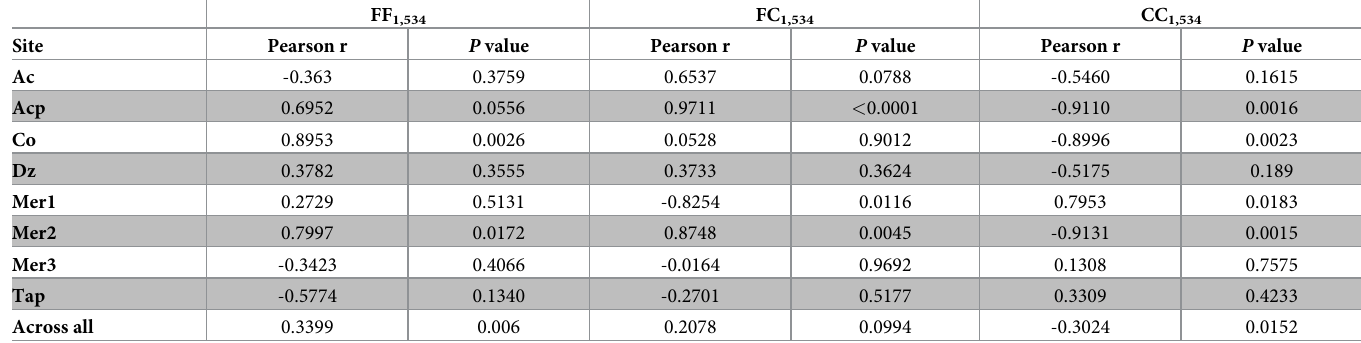
Table 3. Pearson’s correlation coefficient between the genotypes at locus F1,534C and generations in the absence of insecticides. Susceptible-homozygote = FF 1,534 , heterozygote = FC 1,534 , and resistant-homozygote = CC 1,534 .